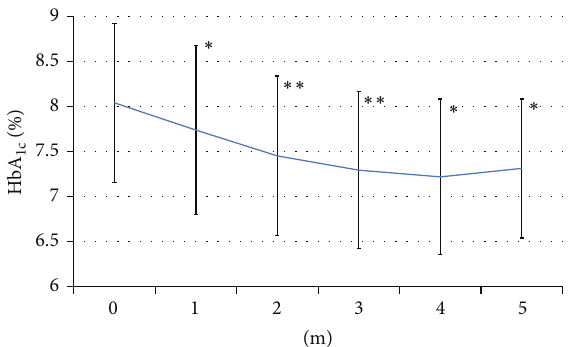
Figure 1: Changes of HbA 1 pared with baseline. ∗ 𝑃 < 0.05 . ∗∗ 𝑃 < 0.01 by the paired t -test (versus baseline). Significance was confirmed by Wilcoxon’s test.